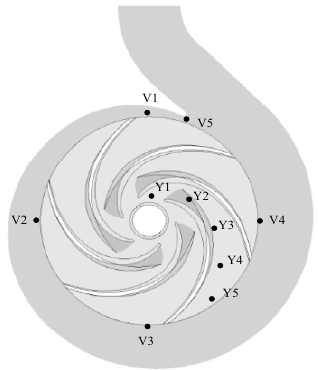
Figure 11. Positions of monitoring points.